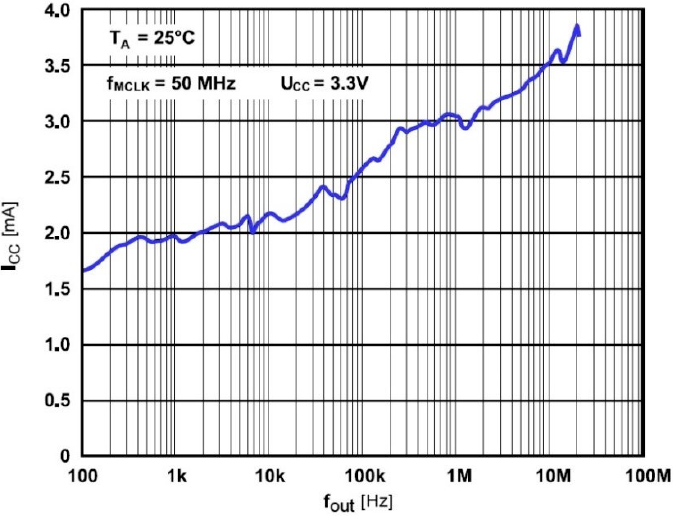
Figure 11. Power consumption of DDC generator as a function of the output frequency. Power consumption of the frequency divider as a function of the supply voltage is shown in Figure 12. The input frequency was 1.47 GHz and the ambient temperature was 25 ◦ C. The divider consumes about 20 mA at V CC = 5 V, which is high and considerably affects the overall power consumption unless appropriate countermeasures are taken. Power consumption of the frequency mixer as a function of the supply voltage is